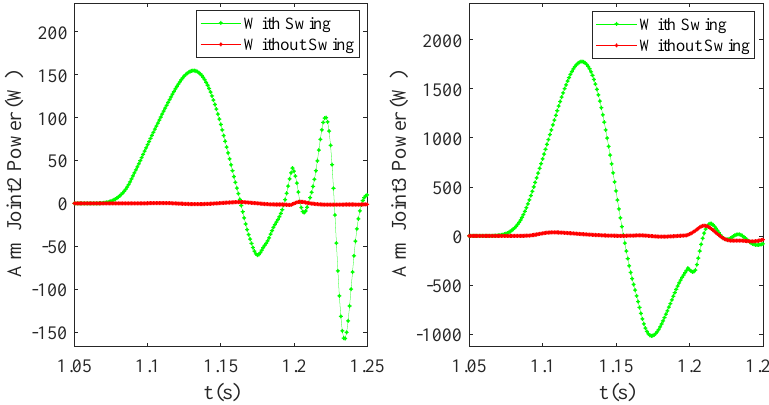
Figure 11. The joint powers of the manipulator during the take-off